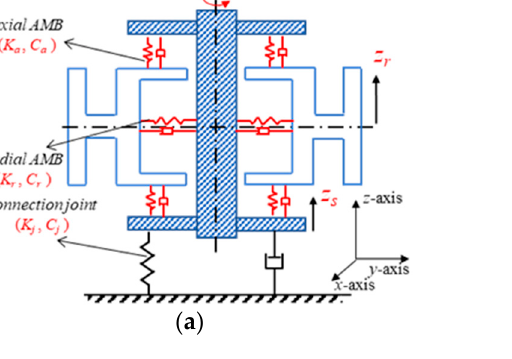
Figure 5. The force models of the 5 ‐ DoF MSMW on the shacking table. ( a ) The equivalent translational vibration model of the 5 ‐ DoF MSMW; ( b ) the equivalent torsional vibration model of the 5 ‐ DoF MSMW.